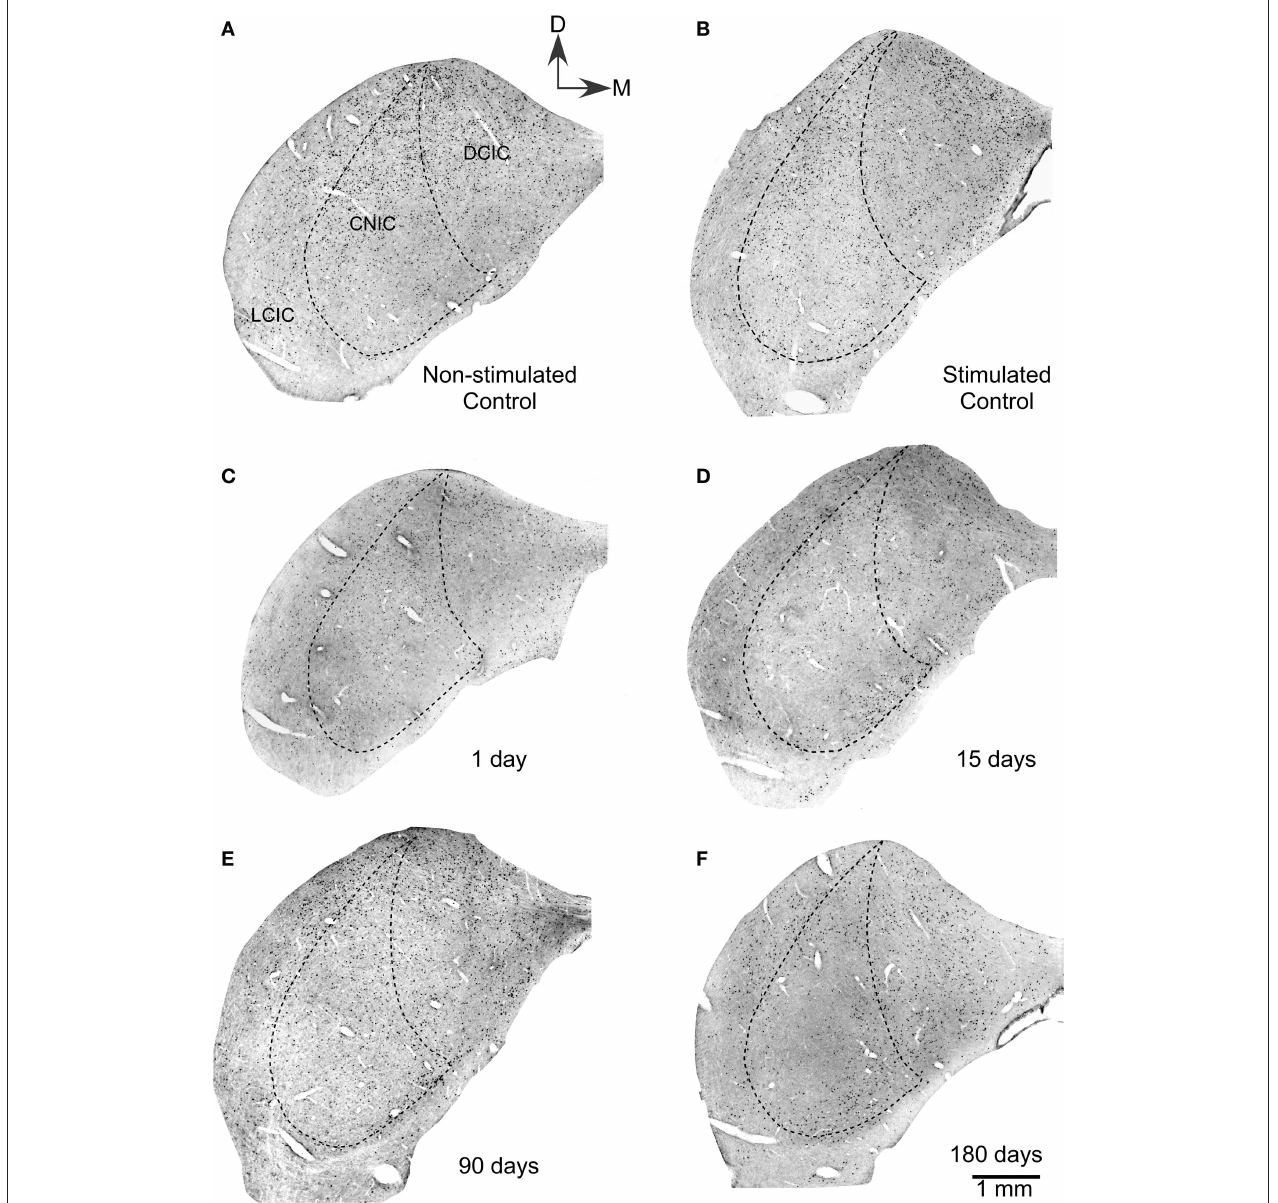
Figure 1 | Low power magnification photomicrograph showing sections of the ipsilateral inferior colliculus immunostained for c-Fos after lesions of the auditory cortex. (A) Non-stimulated control groups showed neuronal nuclei c-Fos Ir in all subdivisions of the IC. Also, in stimulated controls (B) , a large number of c-Fos immunoreactive nuclei are seen in all three subdivisions of control inferior colliculi after sound stimulation. (C) One day after the cortical lesion, sound stimulation induces